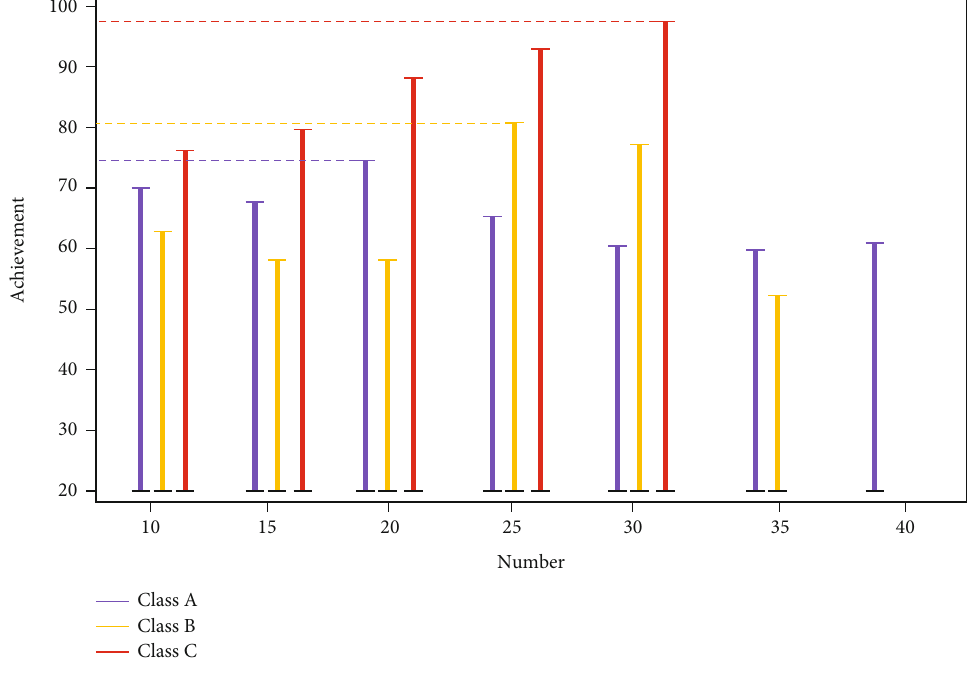
Figure 3: Student achievement change chart of three